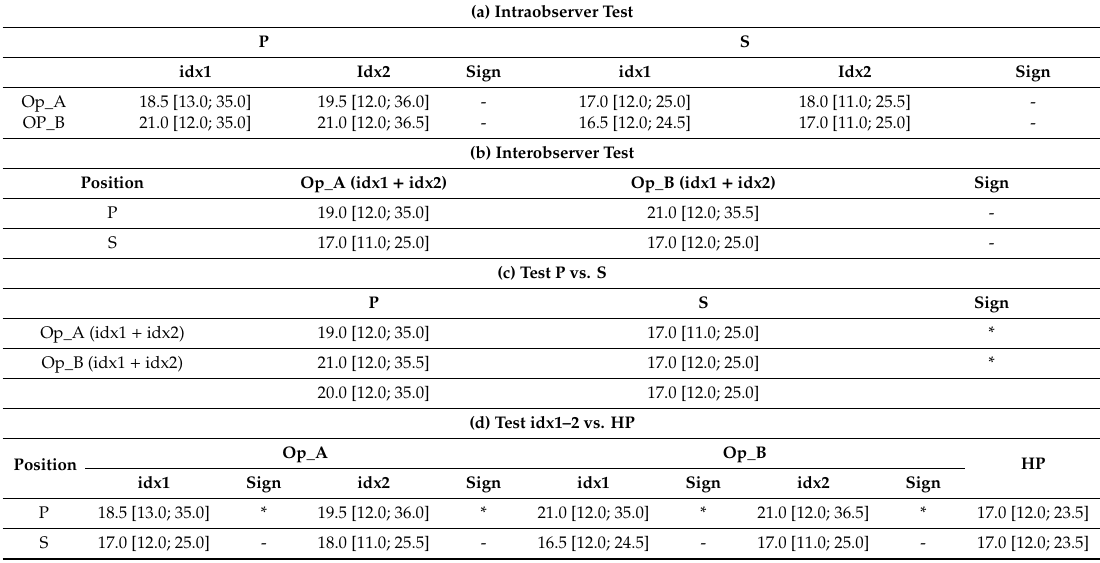
Table 3. p -values of lesion dimensions. ( a ) Intraobserver Test; ( b ) Interobserver Test; ( c ) Test P vs. S; ( d ) Test idx1 – 2 vs. HP.